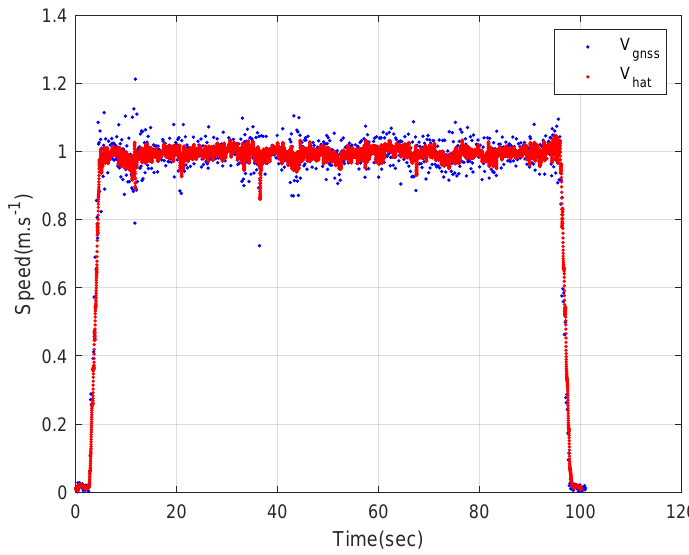
Figure 8. The speed of the rover: a circular driving test. Figure 9 shows the three-axis velocities of the circular driving rover. The blue lines represent the measured GNSS velocities data and the red lines represent the three-axis velocities estimated using the designed integration filter. The estimated results and the GNSS measured results are similar as shown in Figure 9. There exist four peak points of the z-axis velocity estimated using the designed integration filter due to the field condition.